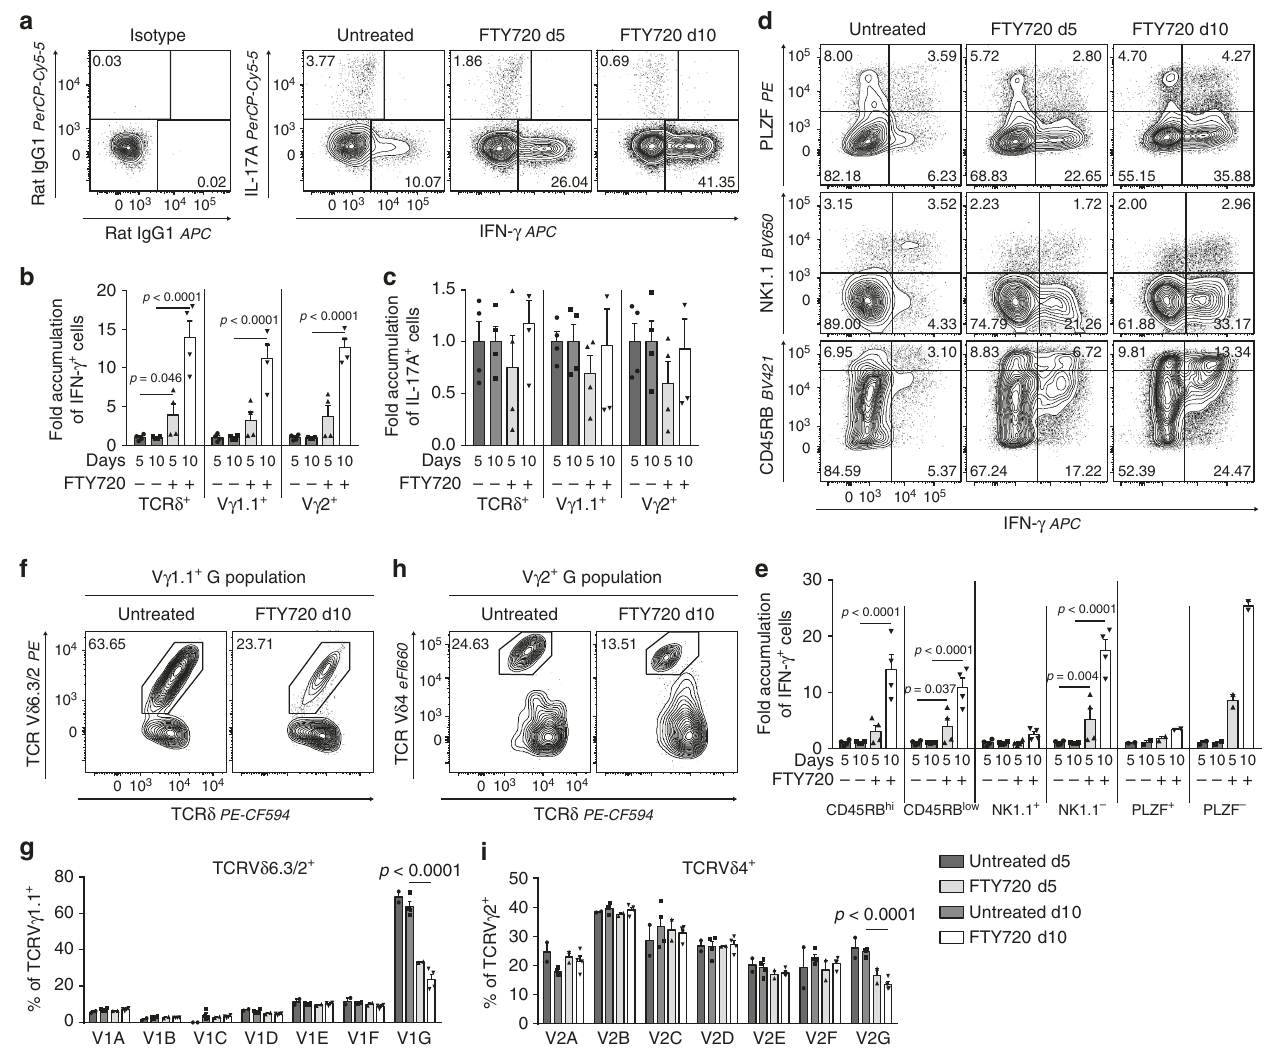
Fig. 6 γδ T1 cells, but not IL-17A + γδ T cells, accumulate when thymic emigration is inhibited. a – c Expression of IFN- γ and IL-17A within TCR δ + cells after treatment with FTY720 for 5 (5d) or 10 days (10d). a Representative fl ow cytometry contour plots and normalised quanti fi cation of the fold change in